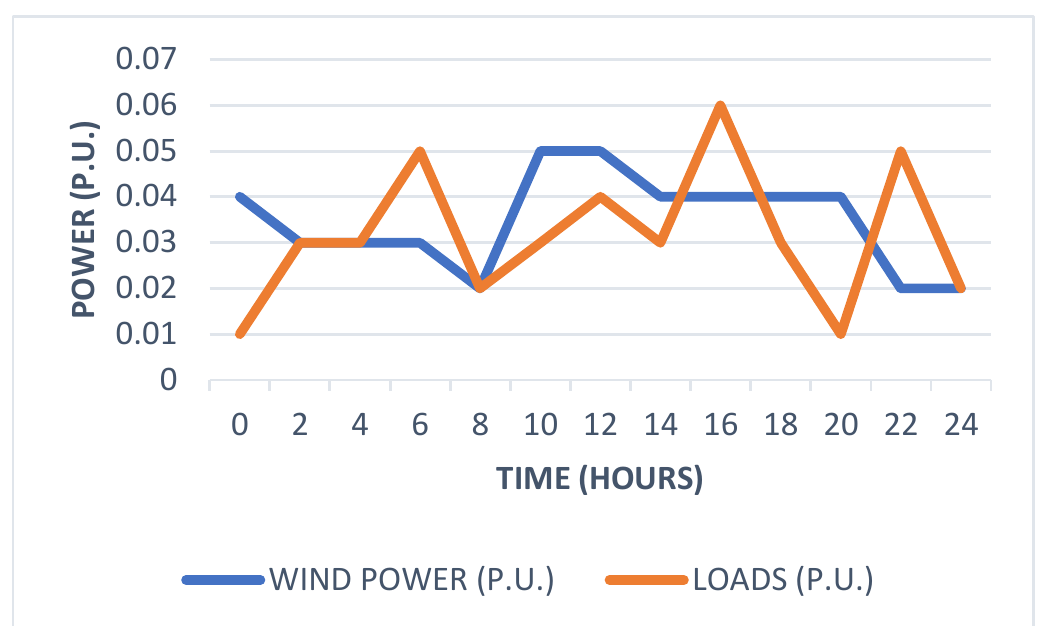
Figure 8. Power profiles for the wind unit generation and loads’ demand within the micro-grid during 24 h.